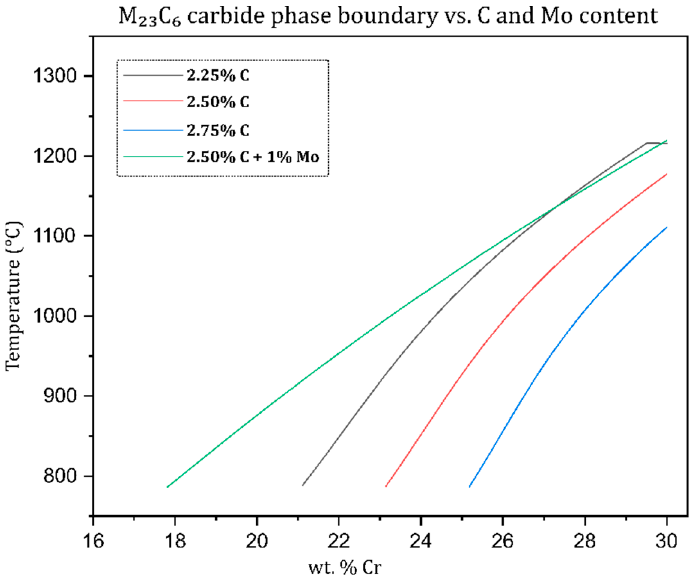
Figure 5. The influence of C and Mo on the phase boundary of the M 23 C 6 carbide predicted by MatCalc 6.